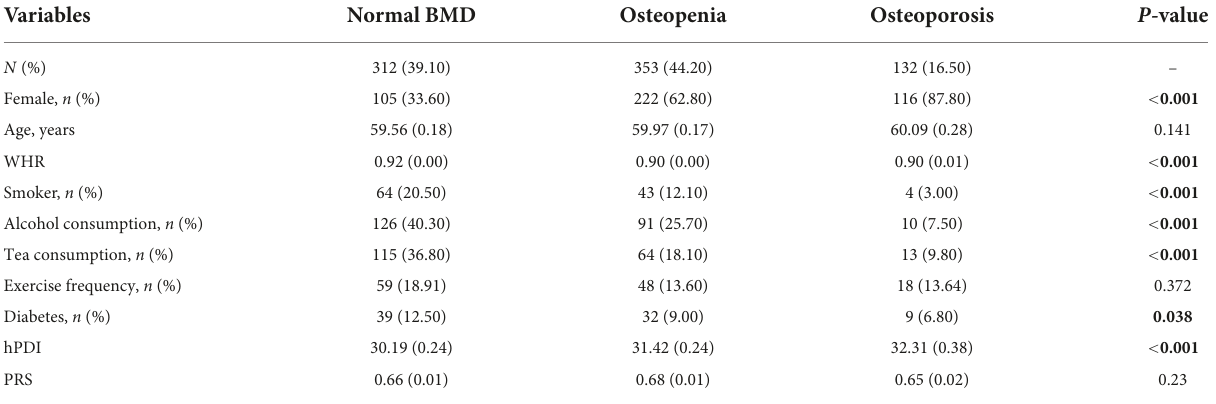
TABLE 1 Characteristics of the study population by